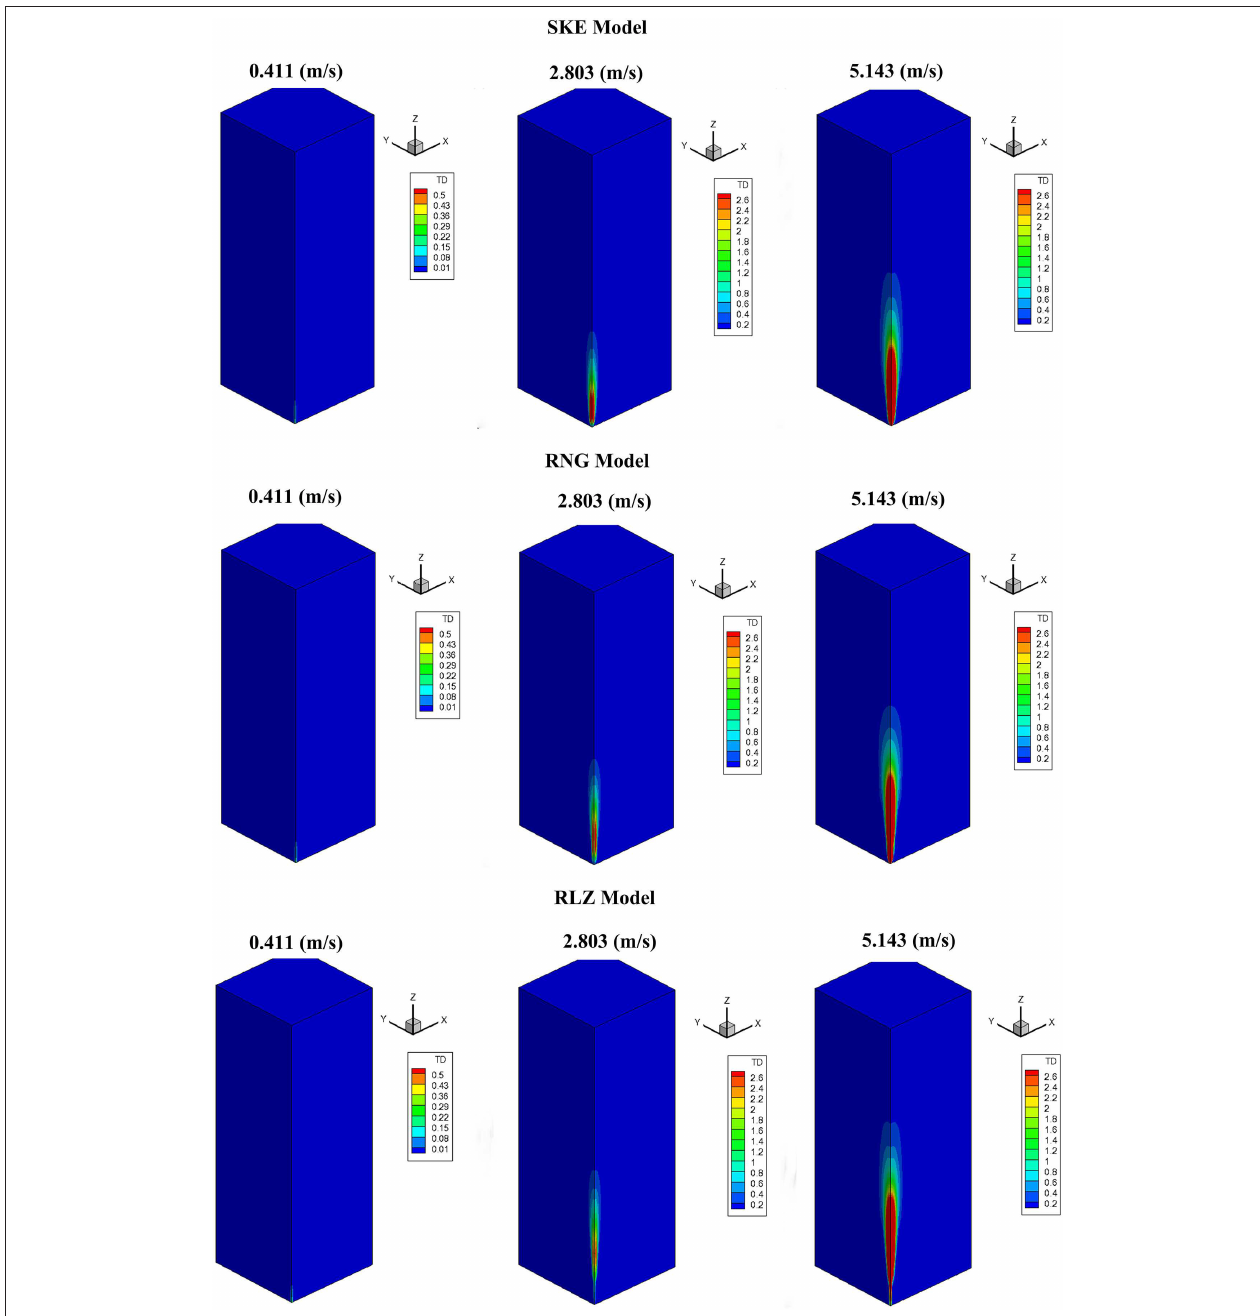
FIGURE 11 | Comparison of instantaneous turbulence dissipation rate (m 2 /s 3 ) calculated by three various air-injection velocities for SKE, RNG, and RLZ at 200 (s).